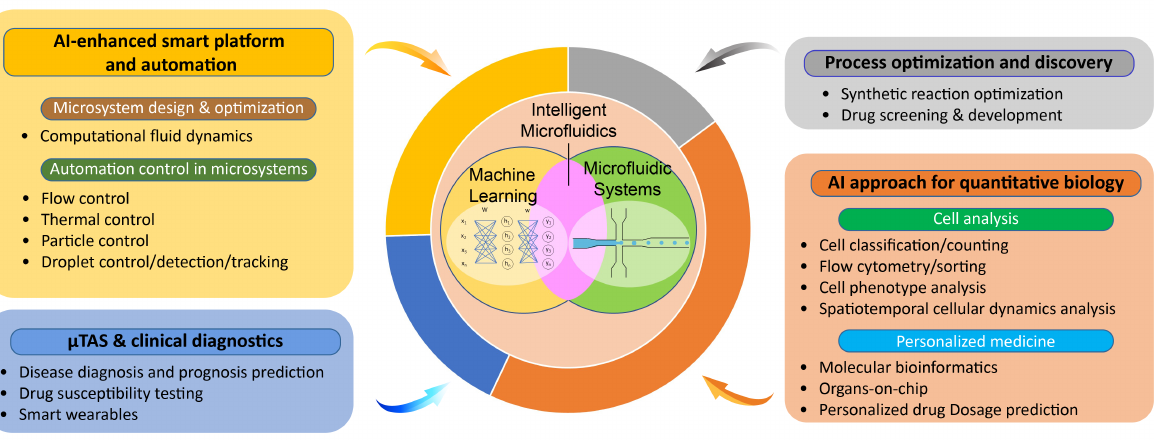
Figure 1. Diagram of microfluidic applications integrated with artificial intelligence (AI). µ TAS stands for micro-total analysis